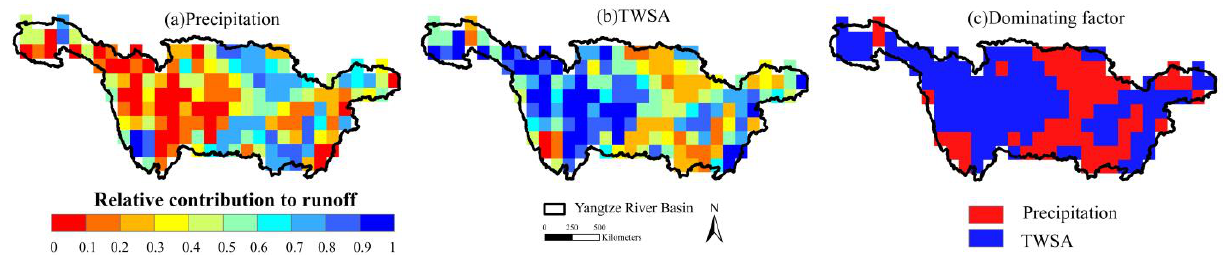
Figure 5. Spatial distribution of contribution of uncertainty in (a) precipitation, ( b ) TWSA, and ( c ) the dominating factor at yearly scale.